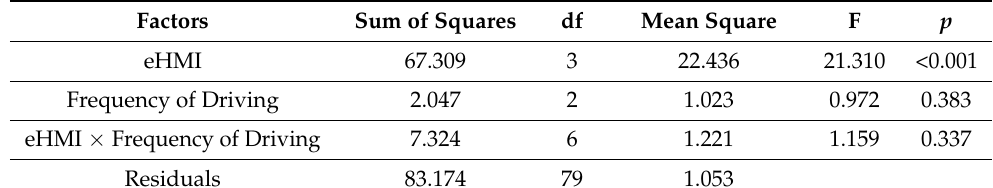
Table 6. ANOVA—the time until over 4 of the willingness to stop scale was reached [45].